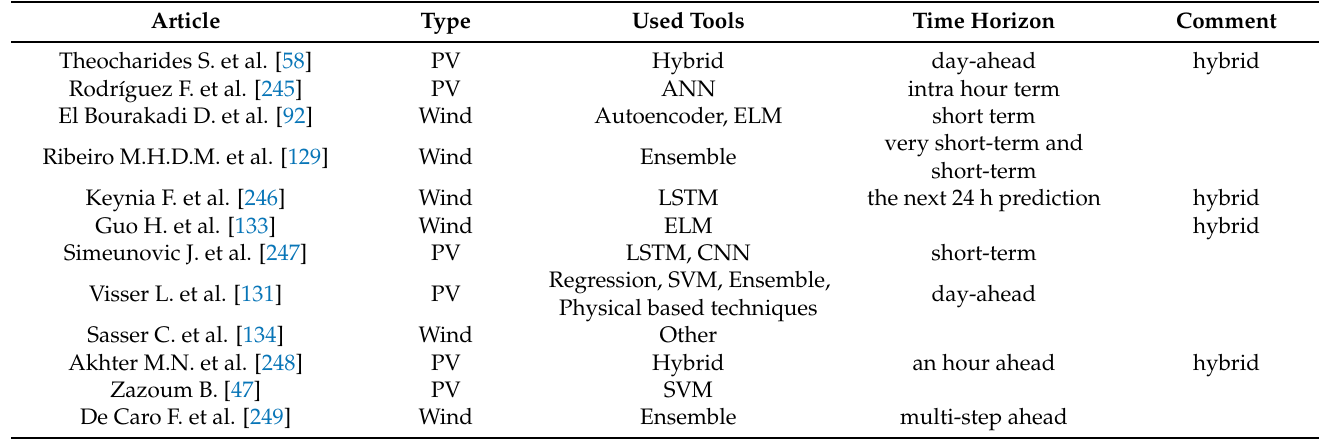
Table A3. An overview and comparative analysis of articles from